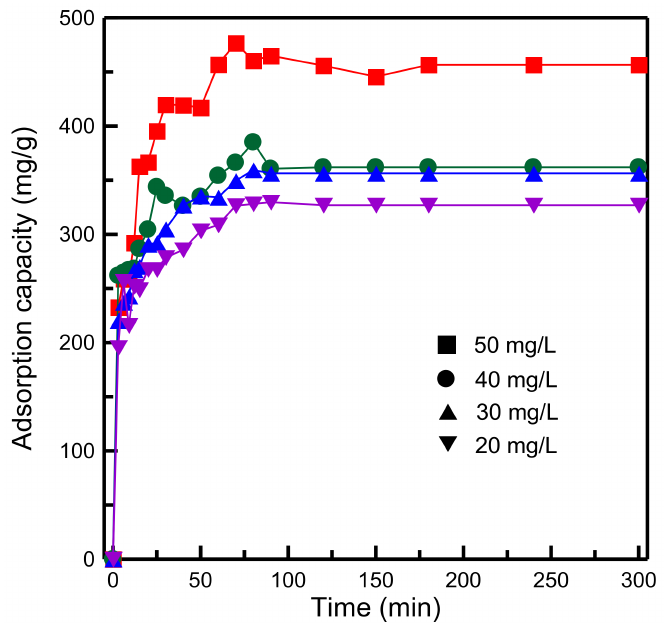
Figure 11. Influence of initial concentration of dye on adsorption capacity of RH-GO/SBA-15. Figure 12 indicates that the dosage of the adsorbent affected the degree of MB adsorp- tion considerably. The adsorption capacity decreased from 510.97 to 226.44 mg/g when the adsorbent dosage was increased from 5 to 30 mg. The higher the adsorbent dosage, the higher the surface area and more adsorption sites were available. However, the decrease in the adsorption capacity for a high adsorbent dosage could be attributed to the adsorption sites remaining unsaturated, which resulted from the increase in the number of available adsorption sites. A similar observation was reported for the capture of chromium (III) ions on zeolite A when using raw kaolin as the silica source [42].